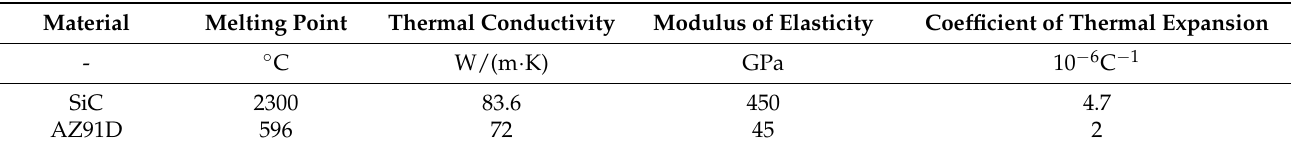
Table 2. Physical and mechanical properties of AZ91D magnesium alloy and SiC.